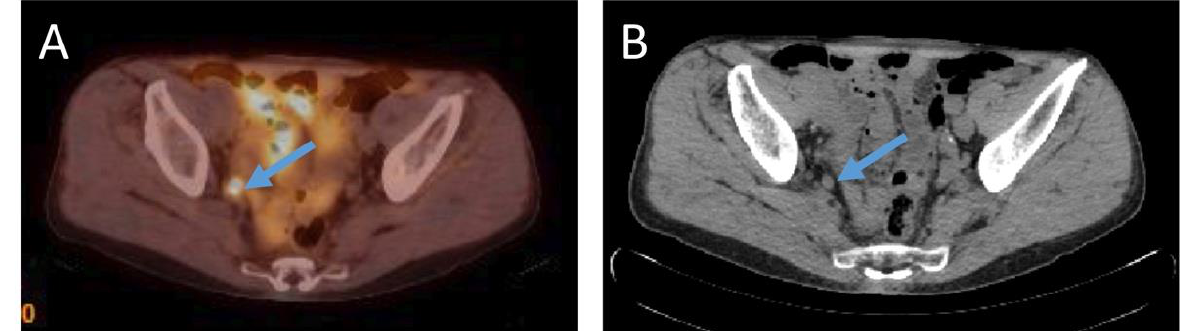
Figure 2. ( A )— 18 F-PSMA-1007 PET/CT examination of a patient (74 years old) after radical prostate- ctomy ten years before, Gleason Score 6 (3 + 3), current PSA level 4.77 ng/mL. 18 F-PSMA-1007 uptake in an 8 mm in size obturatory right side lymph node with SUVmax = 13.7 was detected. ( B ) an 8 mm in size round shaped obturatory right side lymph node in corresponding computed tomography image in axial plane (Images from Riga Stradins University Radiology research laboratory